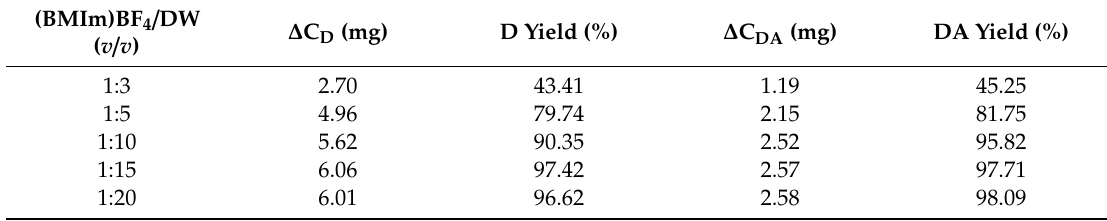
Table 7. Concentration di ff erence ( ∆ C) and yields of D and DA depending on the DW composition